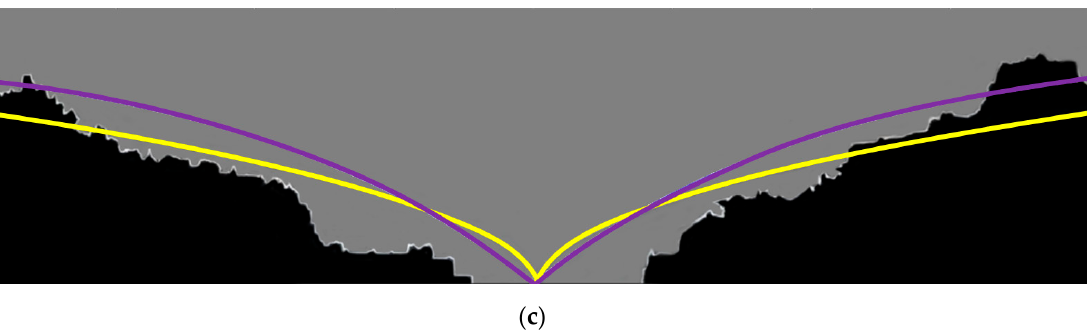
Figure 18. Comparison of the solvent chambers estimated by exponential model, solvent chambers estimated by parabolic model [3], and experimentally visualized [3] solvent chambers in test #3 at